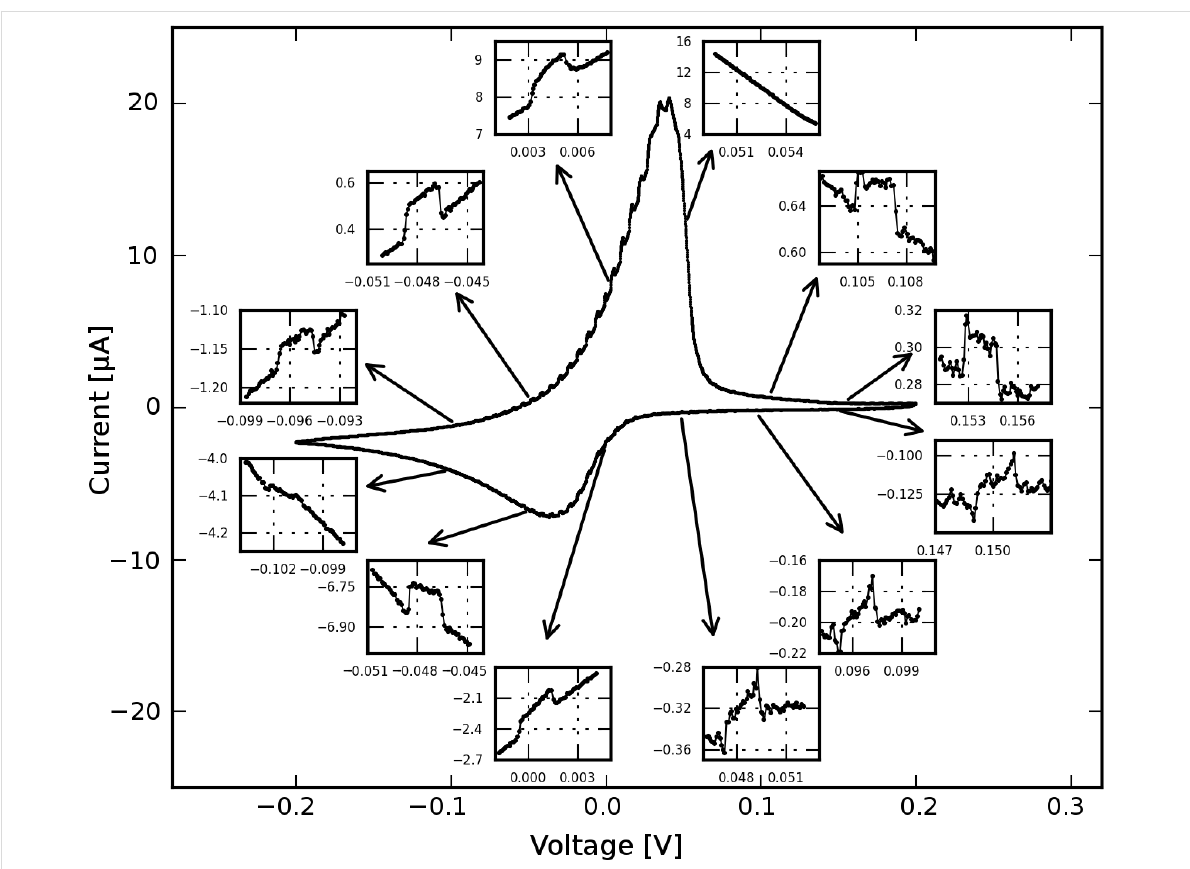
Figure 4: Cyclic voltammogram of AgNO 3 under illumination. Twelve insets of zoomed areas at different potentials are presented here (scan rate is 20